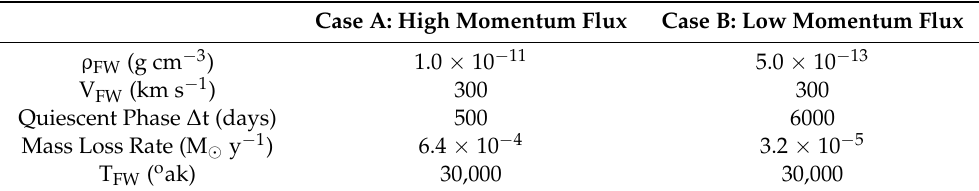
Table 1. Parameters for